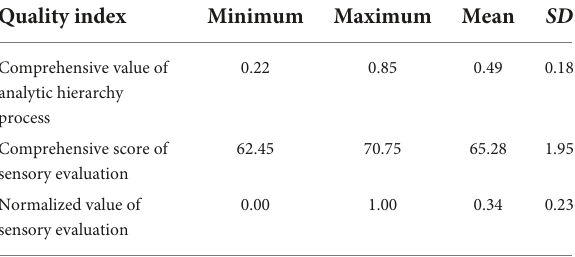
TABLE 10 The comparison of analytic hierarchy process value and sensory evaluation